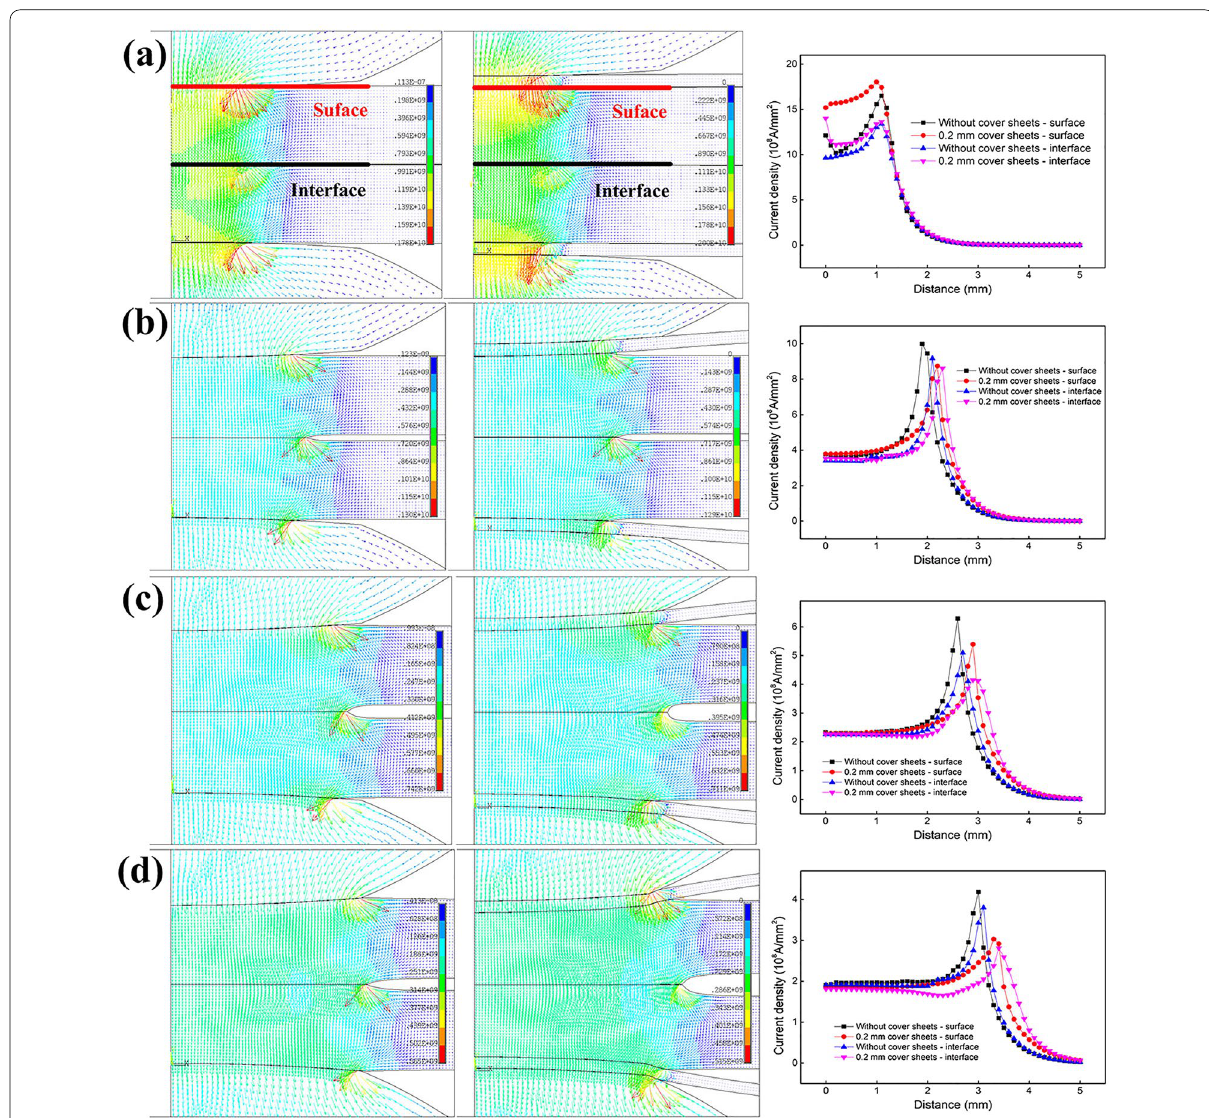
Figure 8 Calculated current density distributions and their variation at the surface and interface of the Q&P980 steel during RSW without cover sheets under 7 kA and with 0.2 mm cover sheets under 8 kA at ( a ) 1 ms, ( b ) 40 ms, ( c ) 120 ms, ( d ) 400